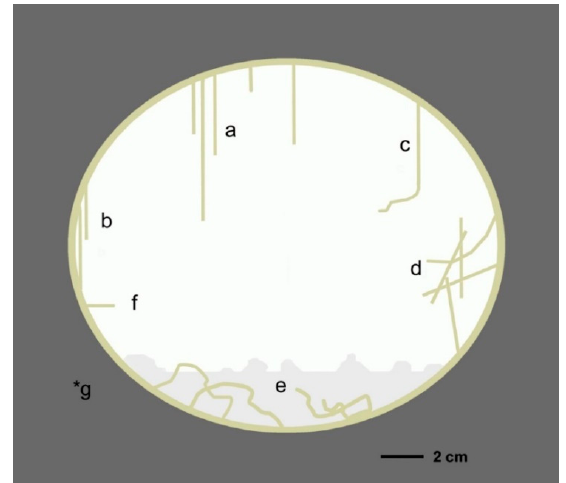
Figure 7. Schematic sketch of a cavity in the lava flow core line with a wide variety of macroscopic morphology of SFF: ( a ) Gravity-controlled linear SFF growing downwards from the cavity ceiling into the free space. ( b ) Gravity-controlled linear SFF growing downwards and connected with the side walls. ( c ) SFF starting with gravity-controlled growth and continuing as curved shapes. ( d ) Intergrowths of curved SFF without any specific orientation forming stable frameworks. ( e ) Zone of intergrowths of helical SFF at the cavity bottom, commonly completely embedded in chalcedony of irregular surface. ( f ) Horizontal SFF with lengths of 1 to 3 cm. Free, upwardly developed SFF have not been observed. *g unaltered whole rock in the lava flow core